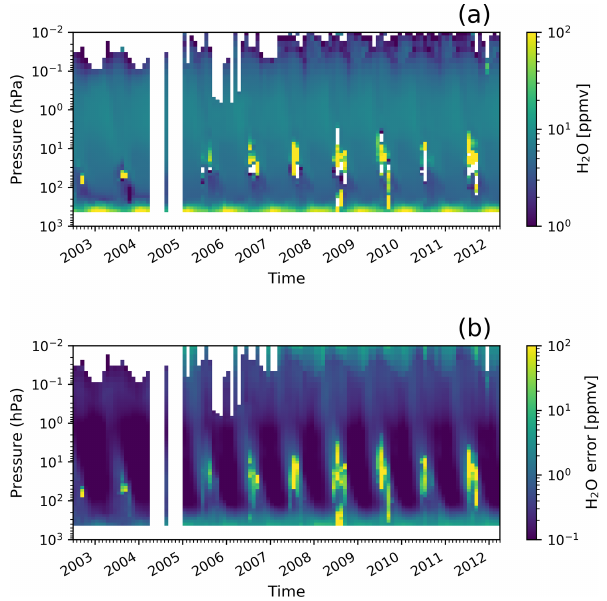
Figure 17. (a) Time series of H 2 O monthly mean profiles in the latitude belt from 60 to 90 ◦ S and (b) corresponding random error when using a CI threshold of